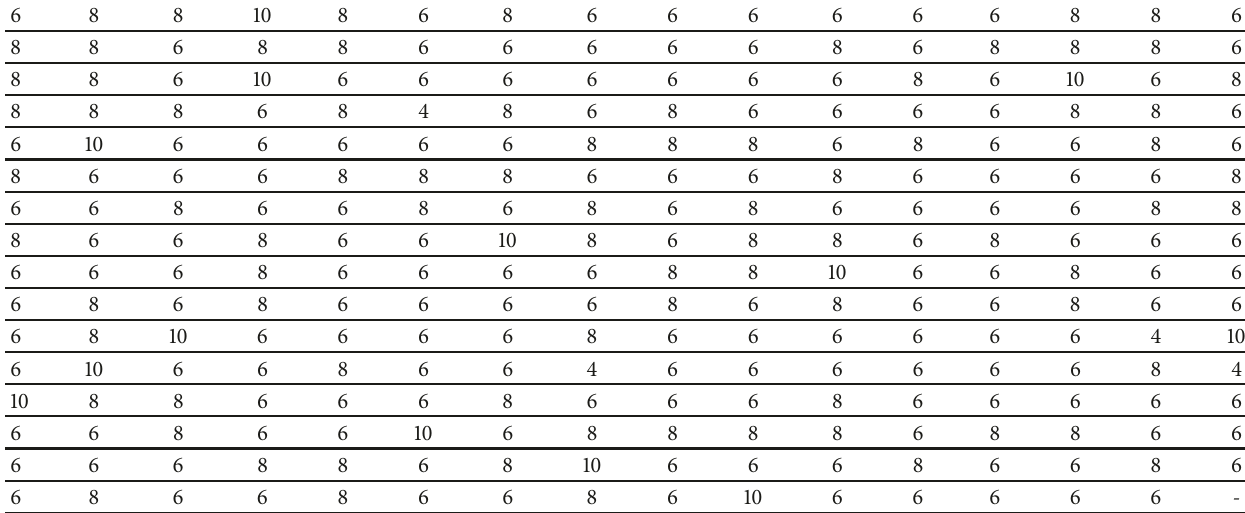
Table 15: I/O XOR distribution for the proposed 8 × 8 S-box.